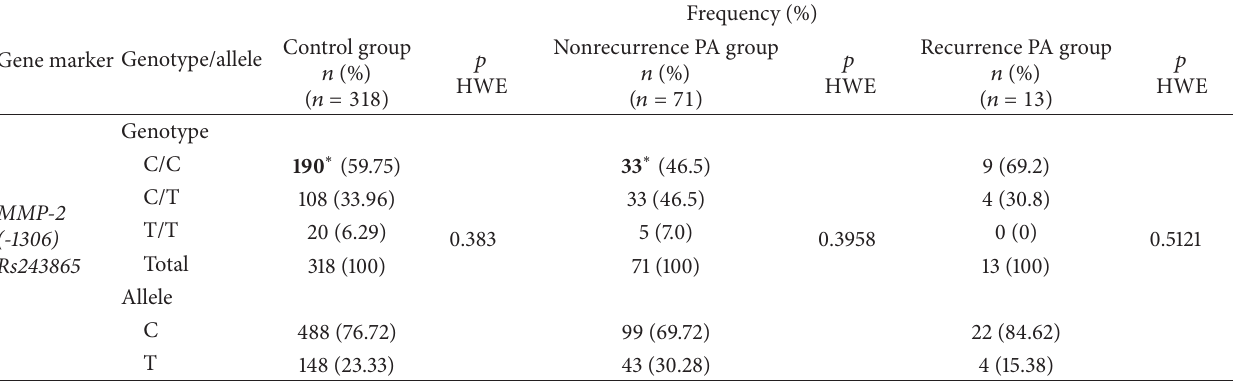
Table 7: Frequency of MMP-2 (-1306 C/T) genotype in the patients with pituitary adenoma (PA) and in the control group by PA recurrences.